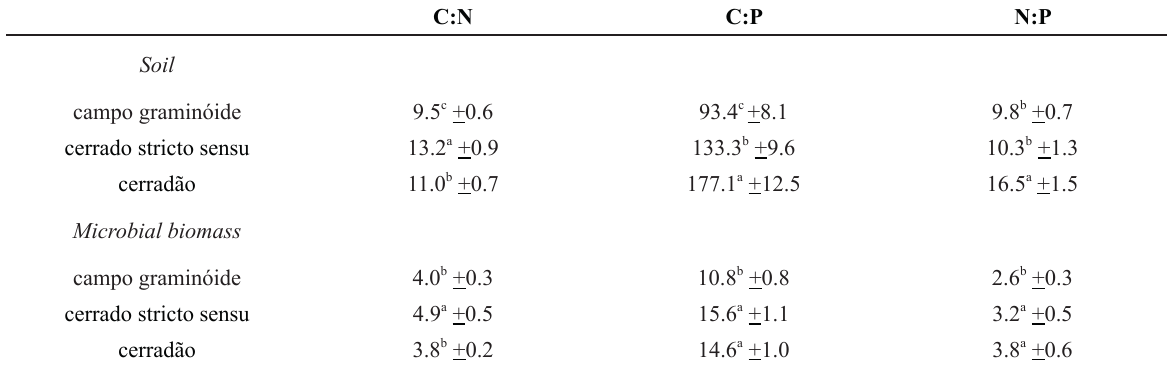
C:N:P ratios in soil and microbial biomass across the Cerrado gradient.